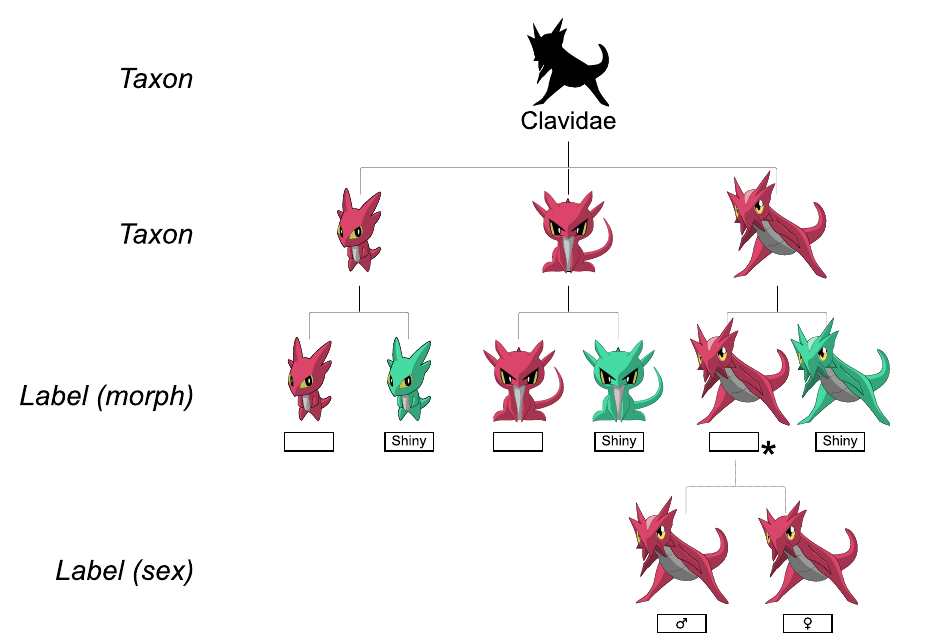
Fig 3. A taxon tree of the Clavidae: Taxa tagged as endpoints are indicated with an asterisk ( � ). This key continues until the correct morph (“Shiny” or default) is known. As the default morph of Clavissima, the species to the right, is defined as an endpoint, no questions regarding the sexes of Clavissima will be asked once its correct morph has been determined.